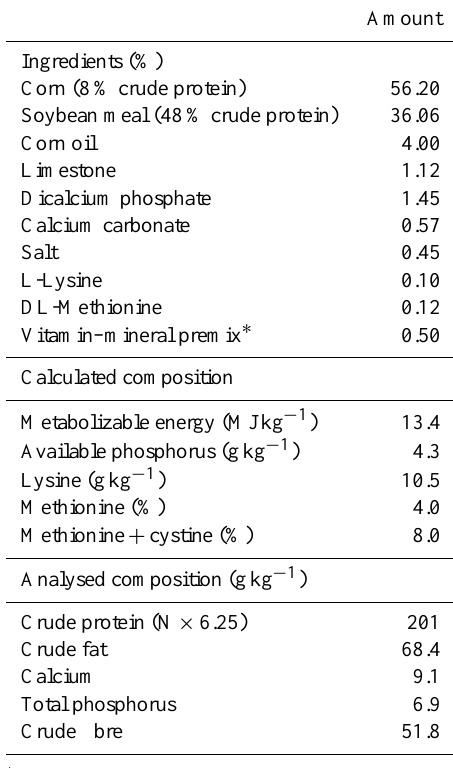
Table 1. Ingredients and calculated and analysed compositions of the basal